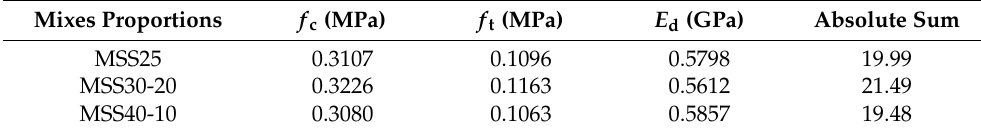
Figure 10. Ternary diagram of the results in the hardened state. Table 6. Normalized results of the hardened mortar properties for 28 days.